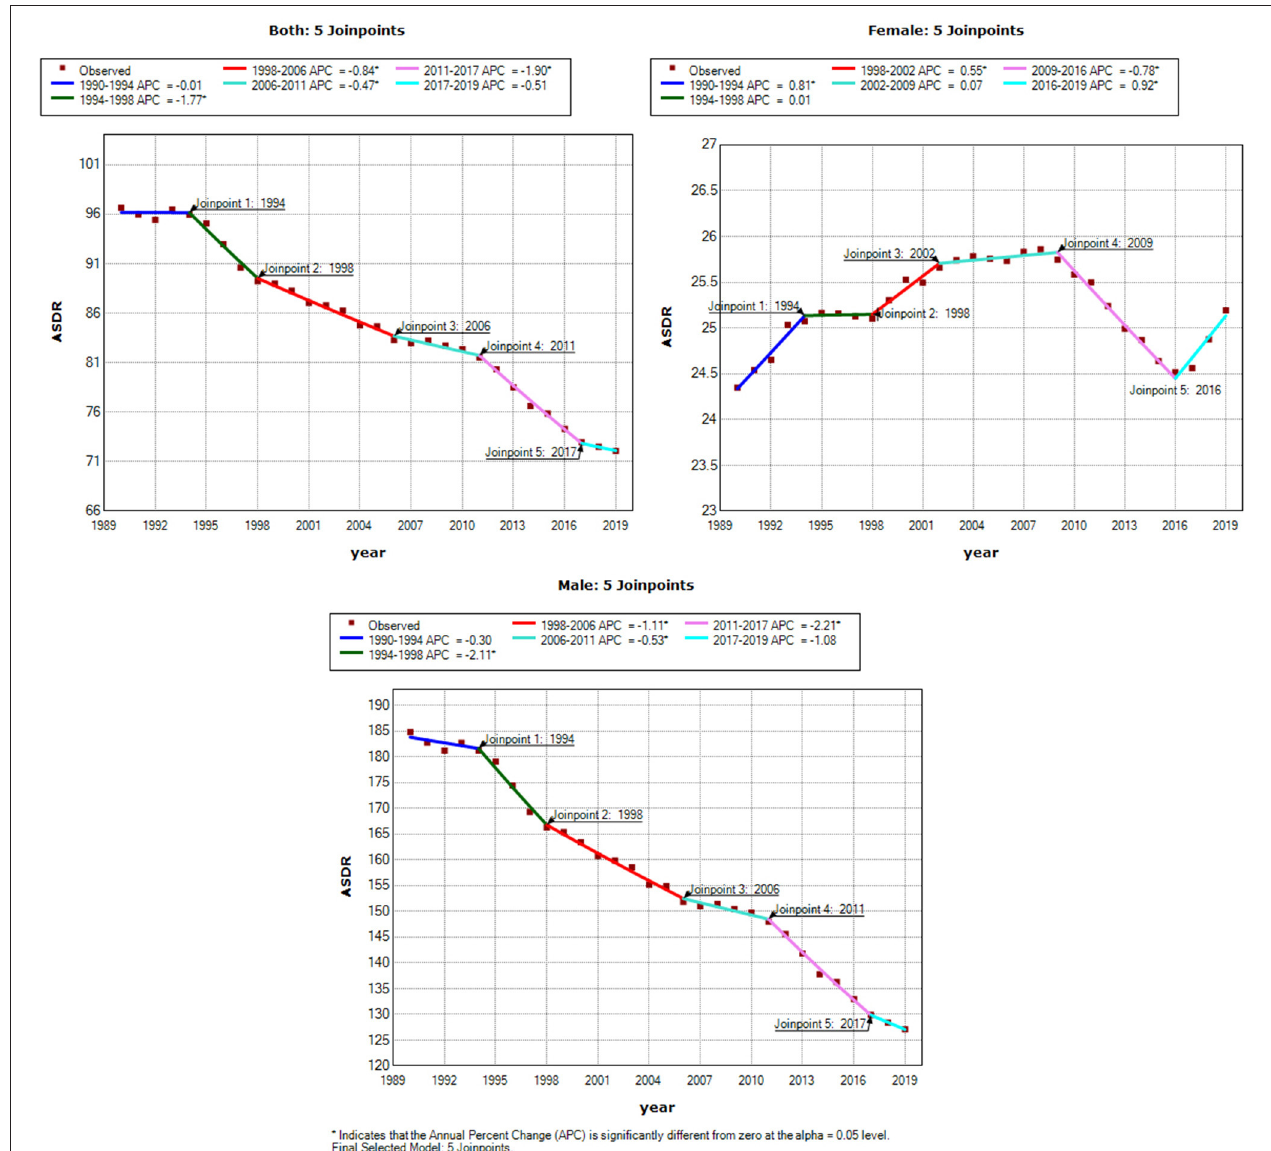
FIGURE 4 | Joinpoint analysis of trend in age-standardized DALYs rates (ASDR) of tracheal, bronchus and lung cancer exposure to occupational carcinogens. APC, the annual percentage